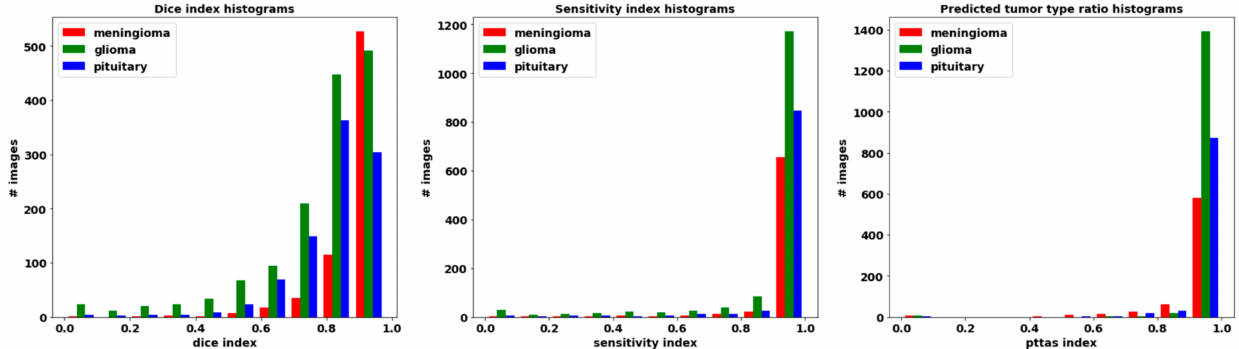
Figure 5. Histograms of metrics obtained after processing the dataset. Left: Dice histogram. Center: Sensitivity histogram. Right: Histogram of the predicted tumor